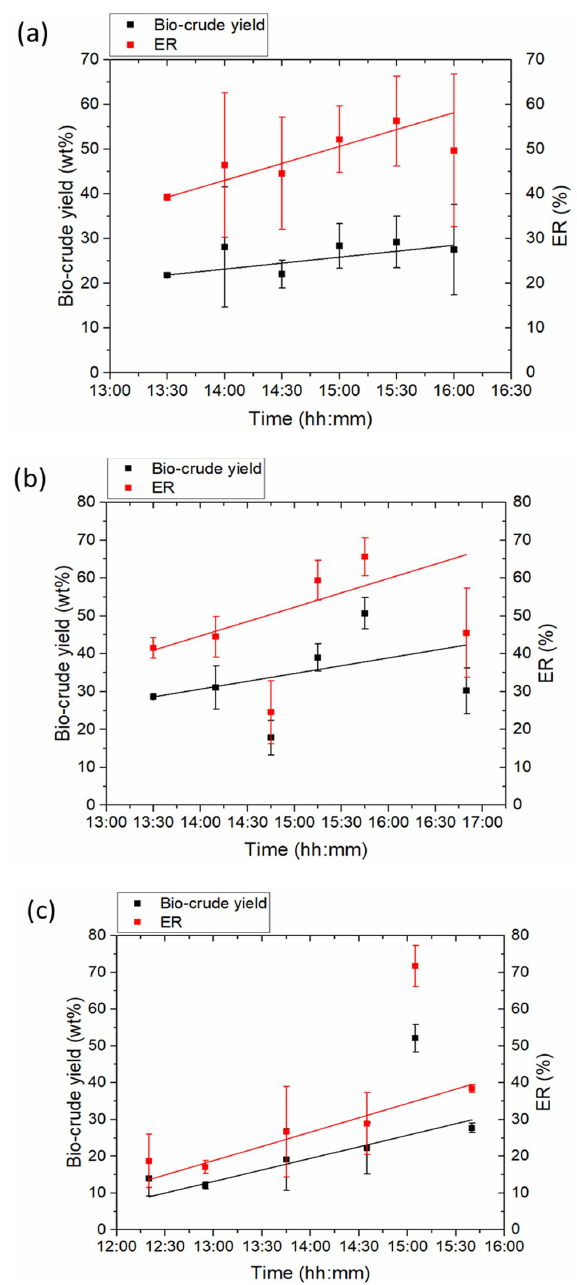
Figure 4. Bio-crude yields and energy recovery (ER) in the bio-crude on biomass input for HTL runs of ( a ) Miscanthus , ( b ) Spirulina and ( c ) sewage sludge over time (straight lines indicate linear fit of the data).